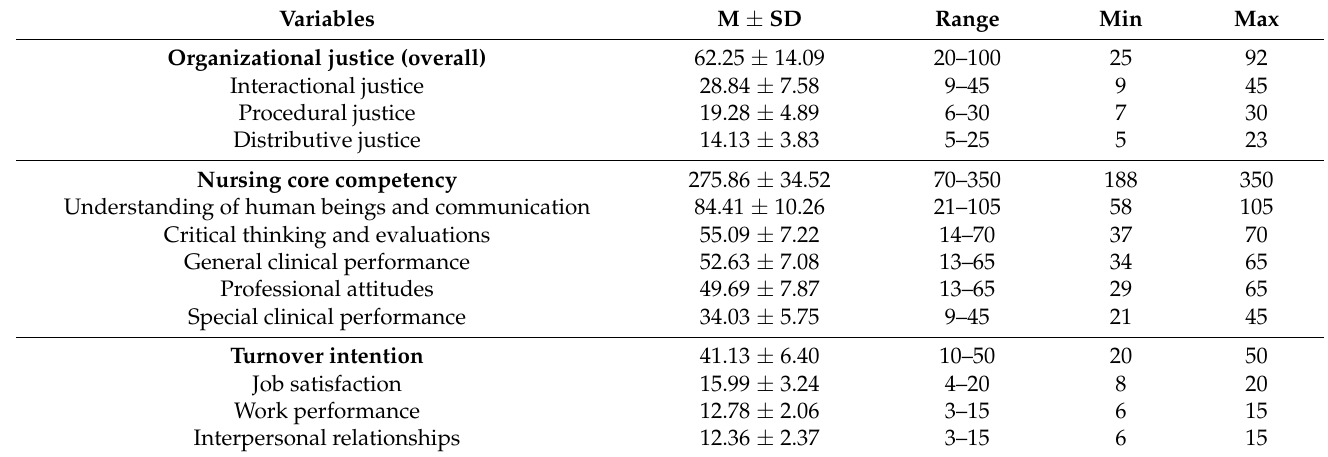
Table 2. Organizational justice, nursing core competency, and turnover intention ( N = 153).